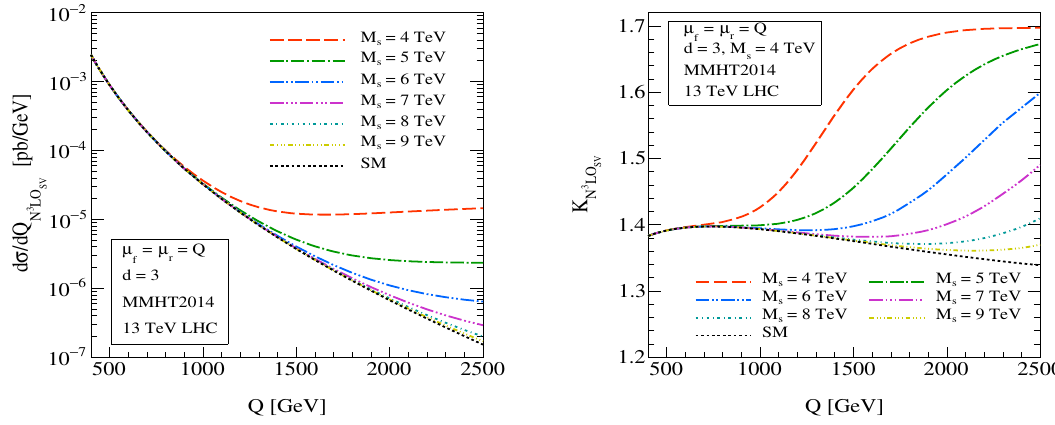
Figure 3 . Invariant mass distribution of di-lepton pair at LHC center of mass energy 13 TeV for signal with d = 3 and di(cid:11)erent M S values. Corresponding K-factors are shown on the right panel at N 3 LO sv level.